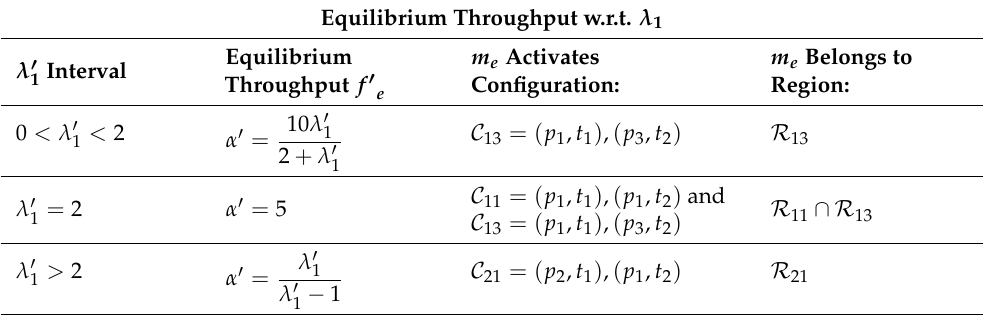
Table 4. Equilibrium throughput w.r.t. λ 1 and its characteristics of the MTS net depicted in Figure 8a. Equilibrium Throughput w.r.t. λ